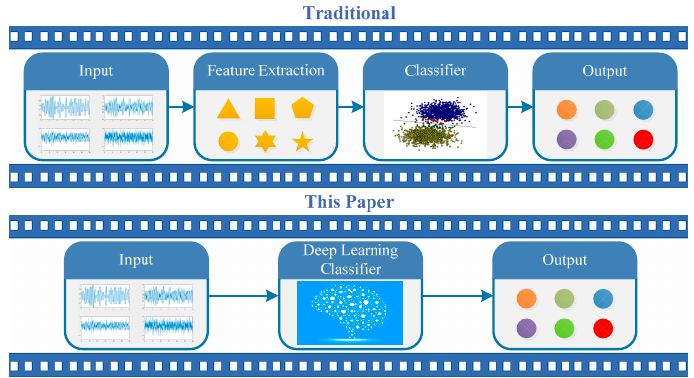
Figure 1. Illustration of the traditional and classifier methods in this study for automatic